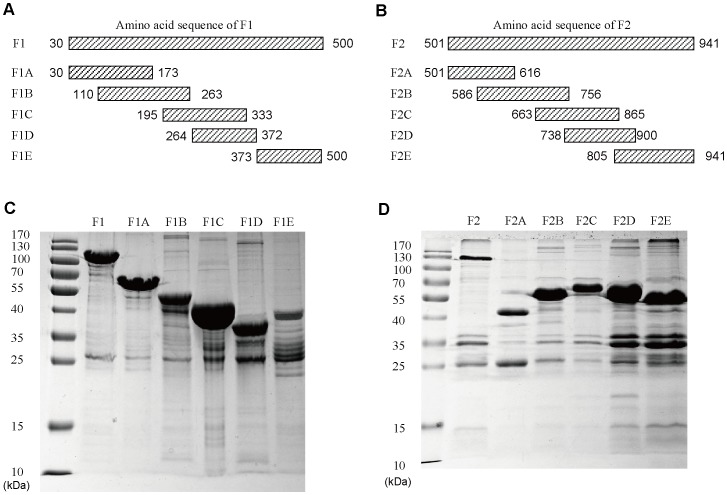
Generation of the fragments of F1 and F2.(A to B) A total of 12 different fragments were produced as GST fusion proteins from the fulllength FnBPA. (C to D) The quality of the GST fusion proteins, F130-500, F1A30-173, F1B110-263, F1C195-333, F1D264-372, F1E373-500, F2501-941, F2A501-616, F2B586-756, F2C663-865, F2D738-900, and F2E805-941, was monitored in an SDS-polyacrylamide gel stained with coomassie blue dye. The molecular masses are shown on the left.